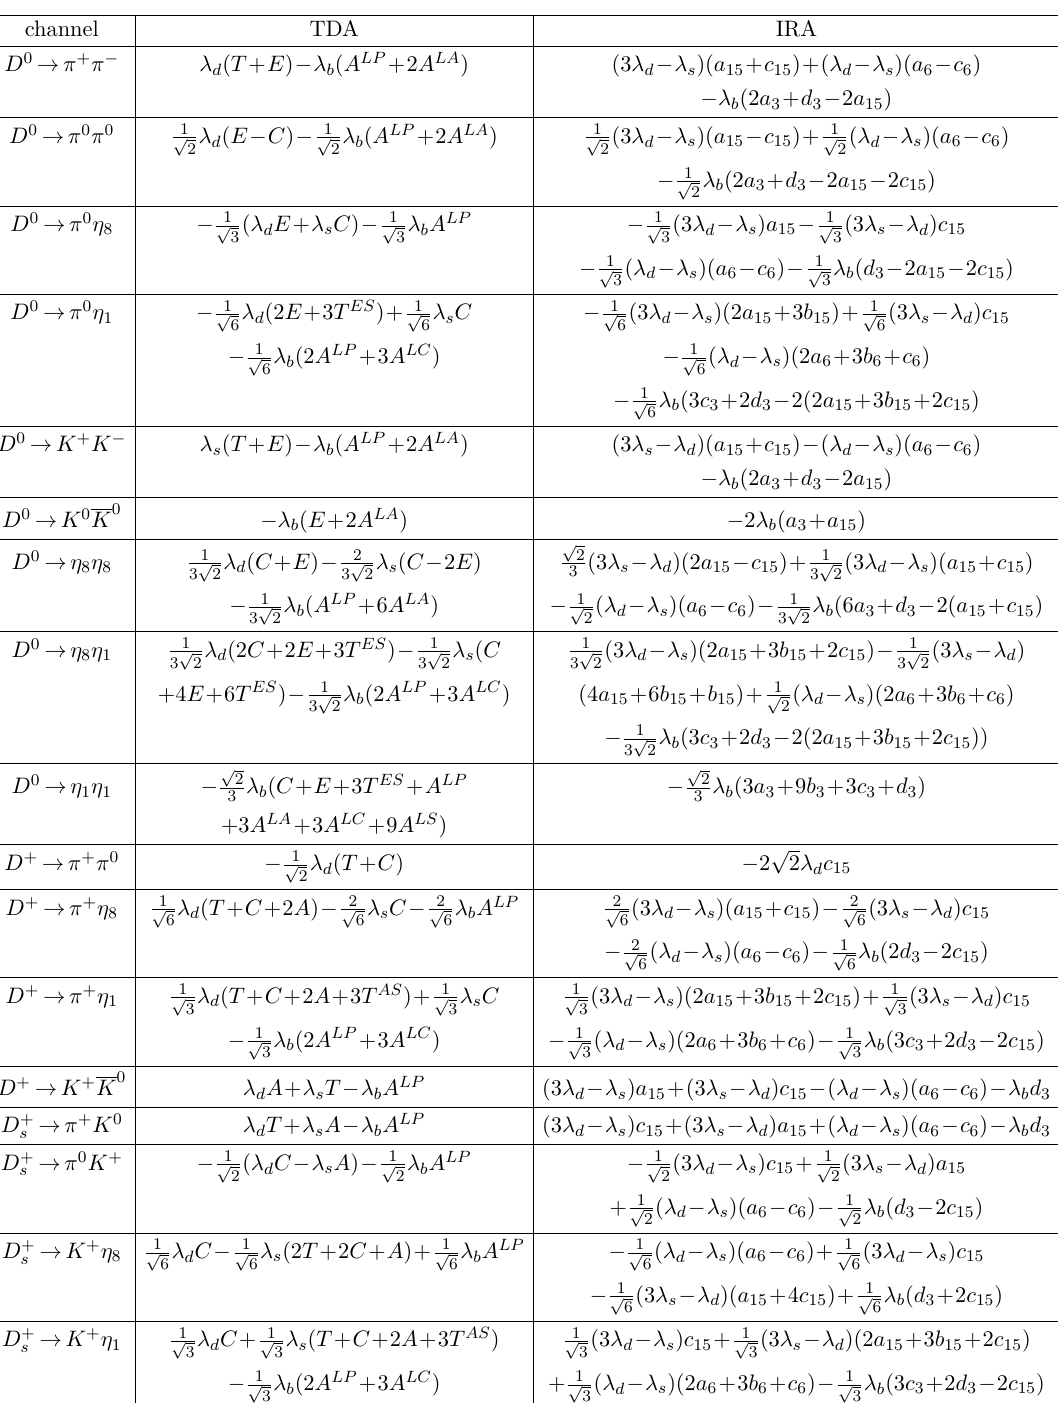
Table 2 . Decay amplitudes of the singly Cabibblo-suppressed D → PP decays. The CKM matrix elements are labeled as λ tions (3.10) and (3.11) are used for